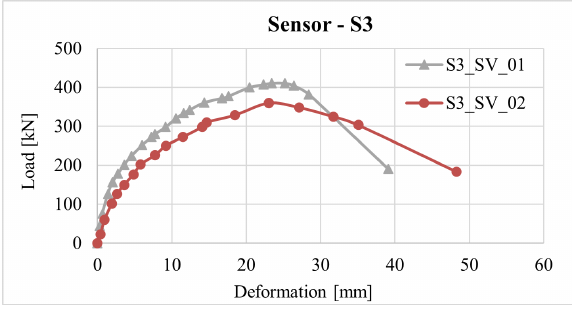
Figure 2. Relationship Load - deformation, sensor